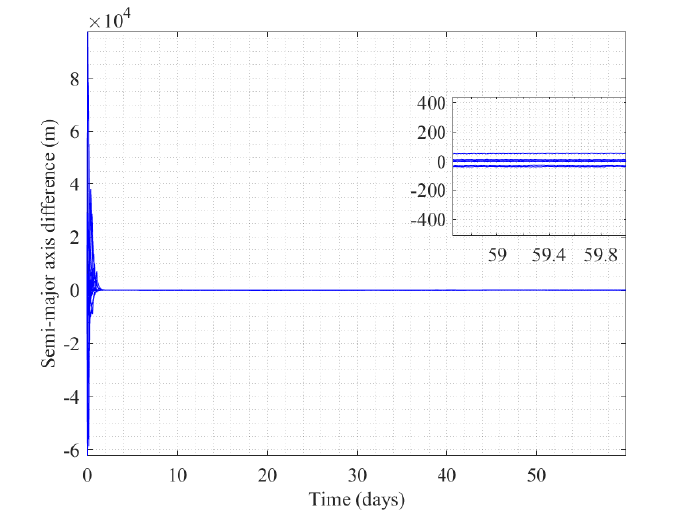
Figure 16. Semi-major axis differences away from the target